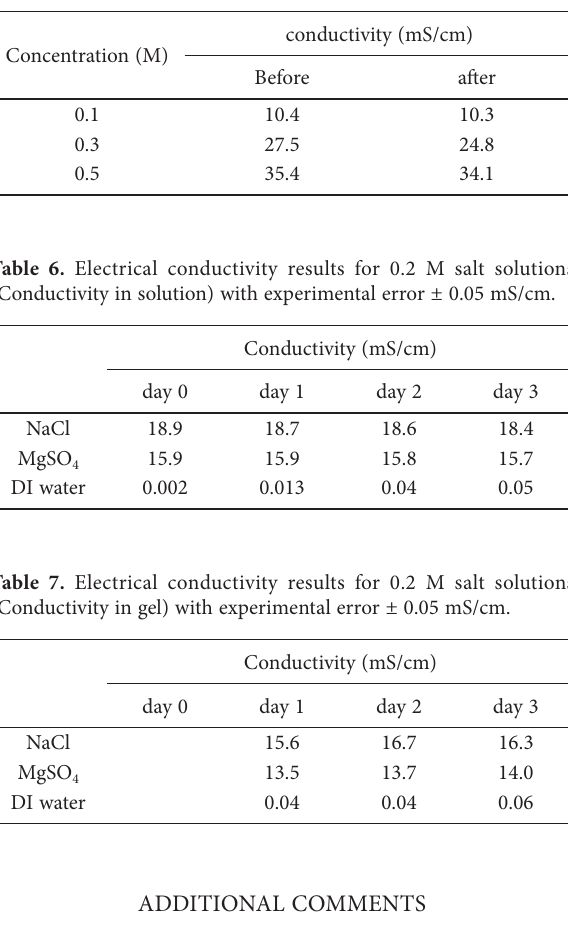
Table 5. Electrical conductivity results for the zwitterionic polymer sample (weight 0.05 g) in 50 mL NaCl solution (with experimental error ± 0.05 mS/cm).